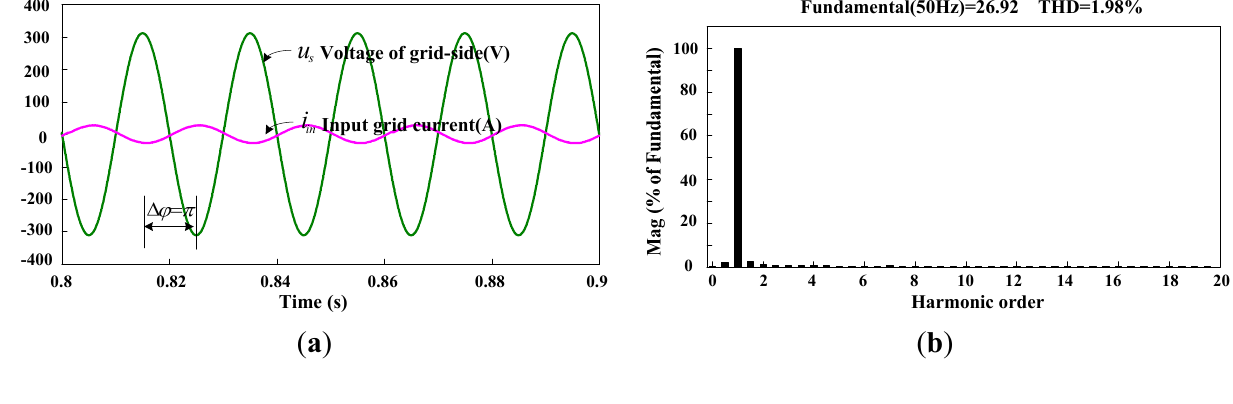
Figure 12. ( a ) Input grid current and grid voltage in grid-connected mode; ( b ) THD waveform of the input grid current in grid-connected mode.